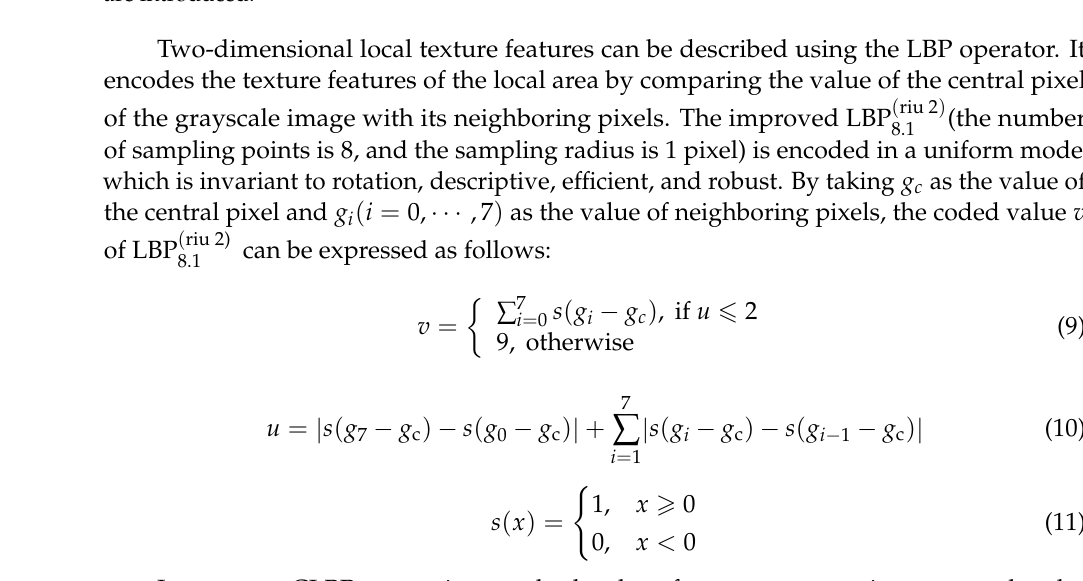
Figure 6. Scene classification. The main process and basic working principle of scene classification are